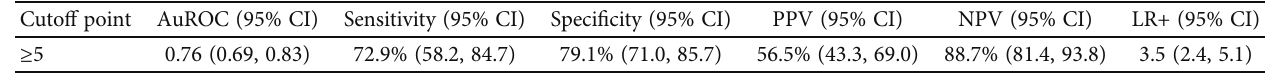
Table 4: Accuracy of the risk score.